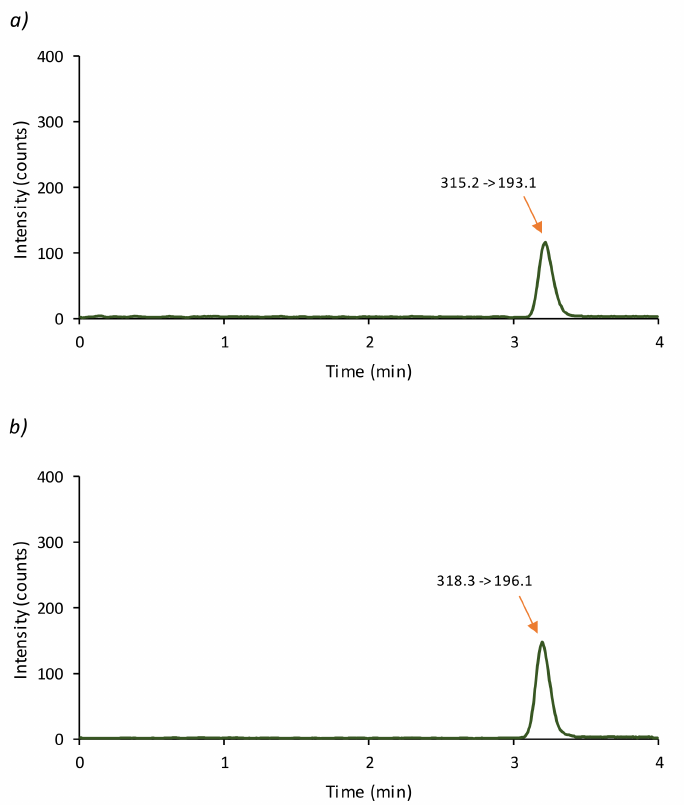
Figure 1. Chromatogram obtained applying the proposed LC-MS/MS method to a standard solution containing 4 ng mL − 1 of analyte and 8 ng mL − 1 of internal standard (( a ) CBD; ( b ) CBD-D3).